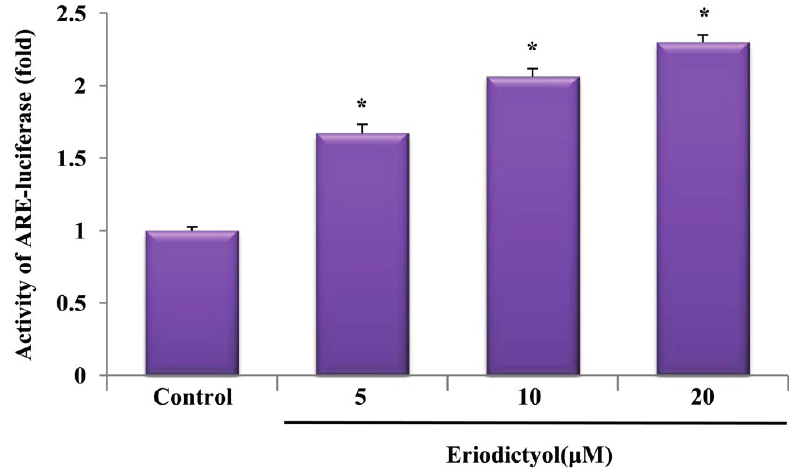
Figure 6. Activation of the ARE-luciferase reporter by eriodictyol. Cells were transfected with an ARE-luciferase construct. After transfection, the cells were treated with the indicated concentrations of eriodictyol for 6 h and the lysates were mixed with a luciferase substrate. A luminometer was used for measurement of luciferase activity. Data are presented as mean ± SD of quintuplicate experiments. * p < 0.05 vs .